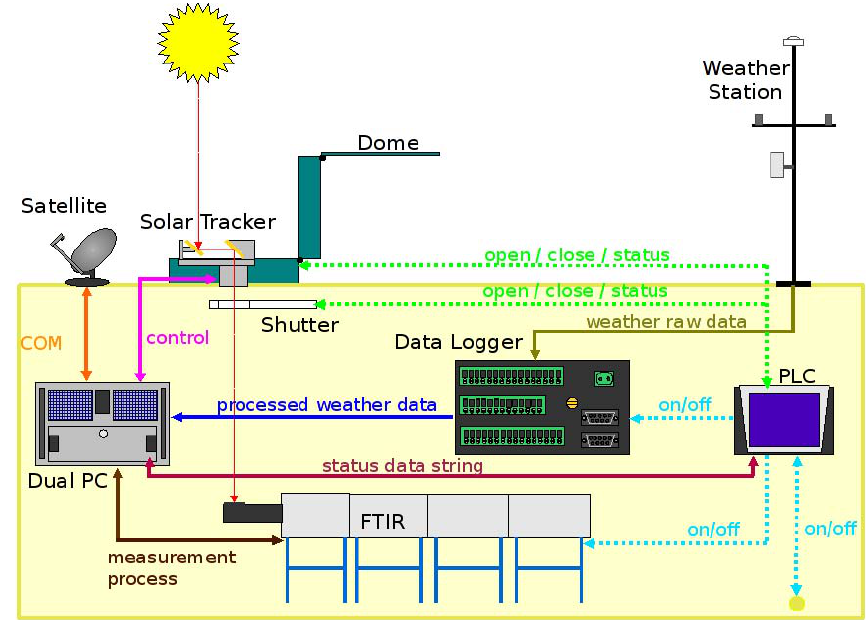
Fig. 2. Schematic overview of the MPI-BGC FTIR system. It illustrates all major parts of the system. The communication flow between the individual components is indicated by